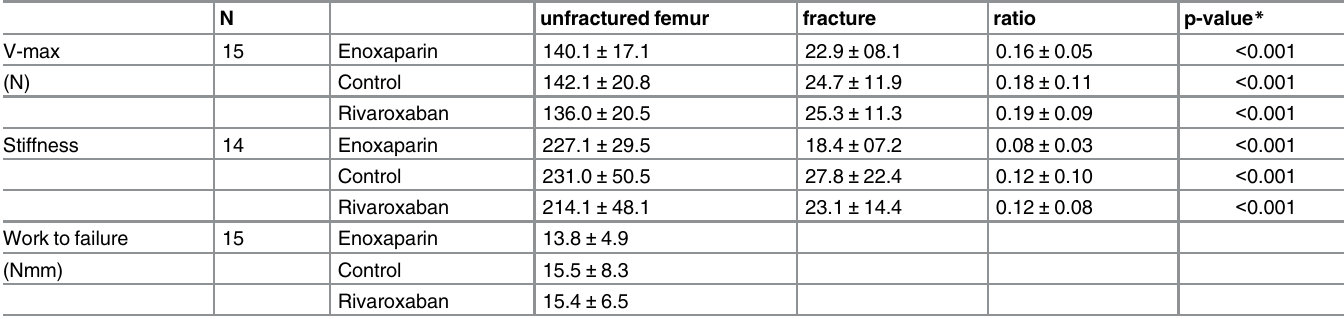
Table 1. Results Biomechanical